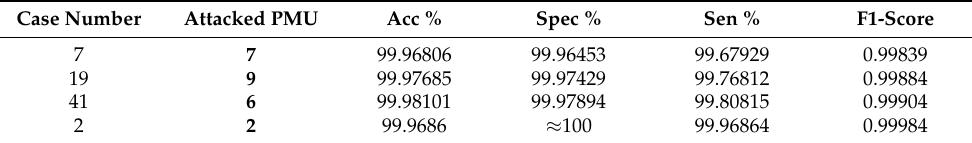
Table 3. Scenario III: Sample results for the IEEE-14 bus